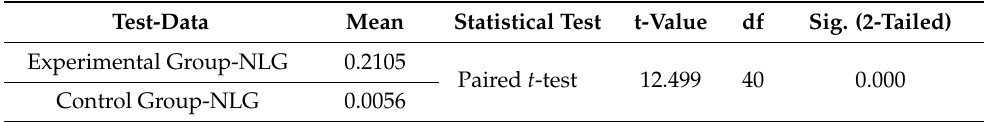
Table 4. The difference in students’ NLG for learning OOP with and without the intervention of